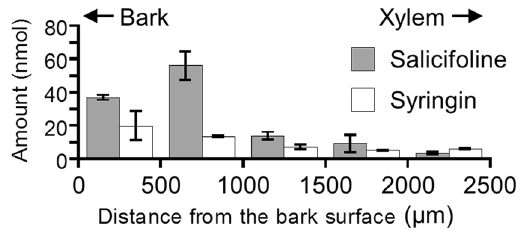
Figure 2. Radial distribution of salicifoline and syringin evaluated by HPLC using serial tangential sections of sample blocks (thickness, 10 mm; circular sector of radius, 5 mm; and central angle, π /16). Measurements were performed in triplicate using three different sample blocks cut from the same